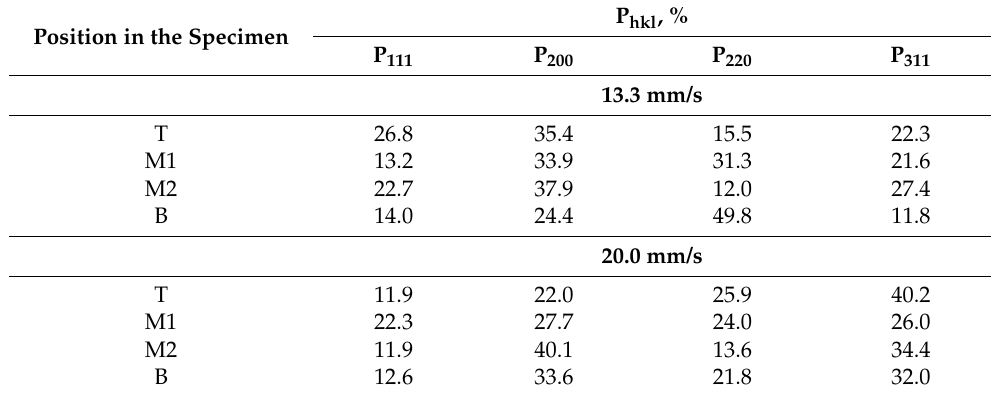
Table 2. Preferred crystallographic orientation in relation to the specimens’ growth. Position in the Specimen